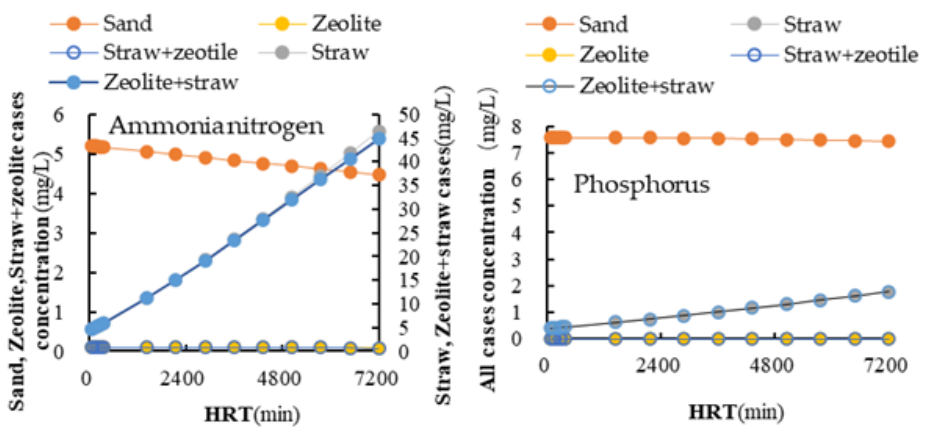
Figure 7. Concentrations with a 10 cm depth of upper soil and no lower soil layer.